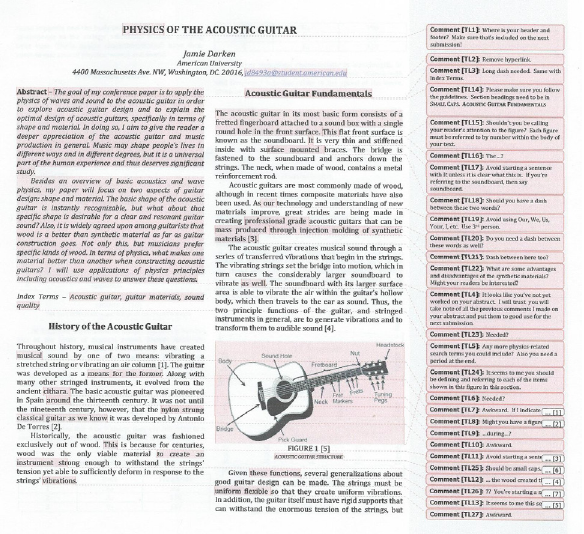
Figure 6. First draft submission and instructor’s feedback.